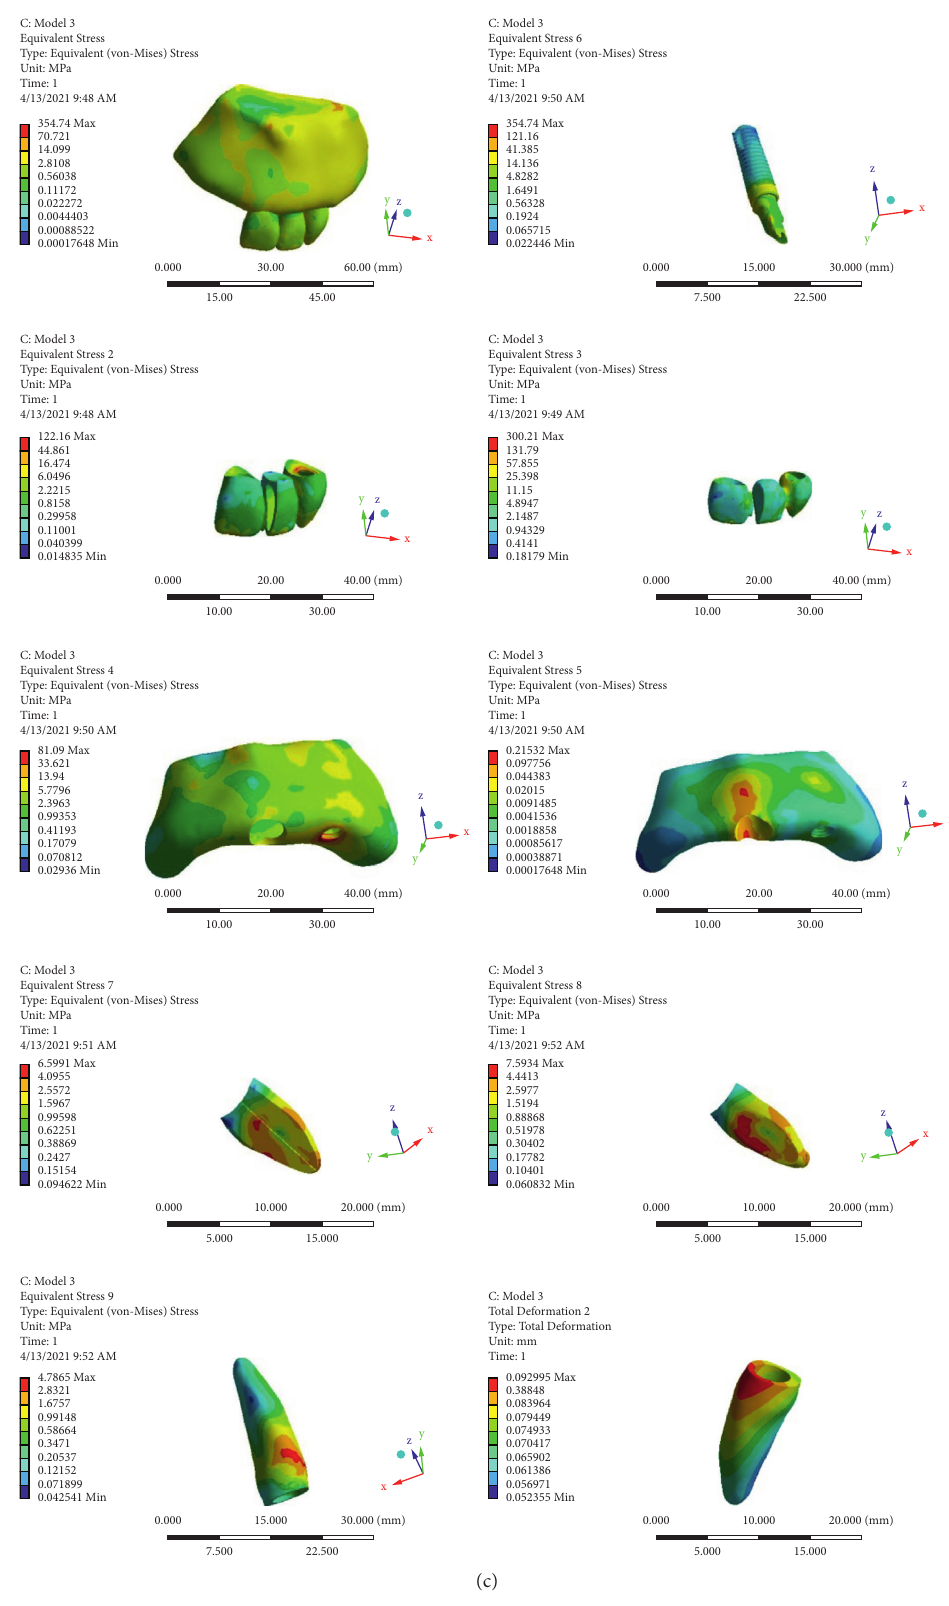
Figure 3: (a) Color spectrums manifest stress distribution of the entire model, implant, porcelain, metal frame, cortical bone, spongious bone and natural tooth (MPa) and the tooth vertical displacement (mm) under vertical loading in the first model. (b) Color spectrums manifest stress distribution of the entire model, implant, porcelain, metal frame, cortical bone, spongious bone, matrix, patrix and natural tooth (MPa) and the tooth vertical displacement (mm) under vertical loading in the second model. (c) Color spectrums manifest stress distribution of the entire model, implant, porcelain, metal frame, cortical bone, spongious bone, matrix, patrix and natural tooth (MPa) and the tooth vertical displacement (mm) under vertical loading in the third